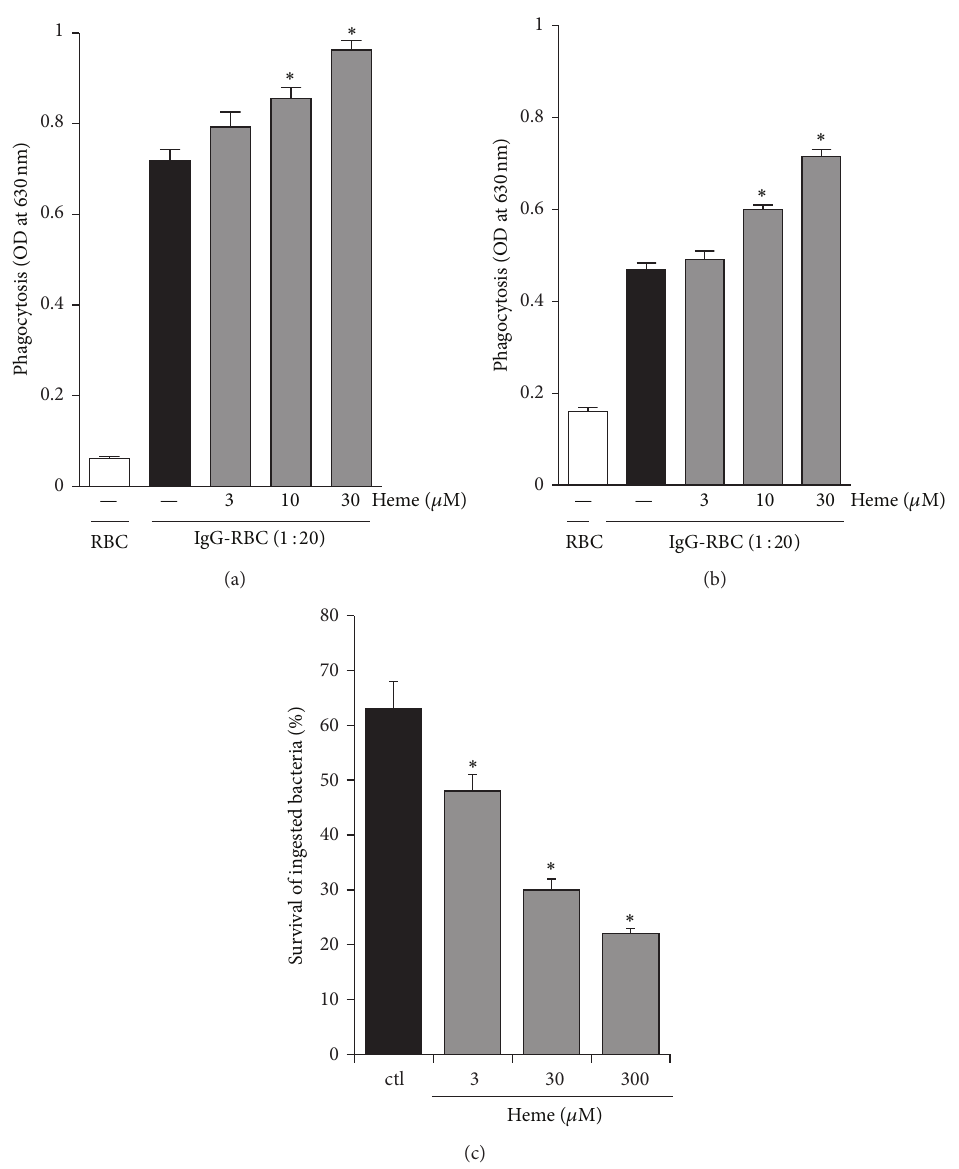
Figure 7: Heme modulates phagocytosis and killing by AM. Rat AMs (2 × 10 6 /mL) were cultured in the absence or presence of heme (3–300 𝜇 M) for different periods of time. (a), (b) Following the incubation with heme for 10min (a) or 24 h (b), IgG-SRBCs were added and cultures were incubated for an additional 90min at 37 ∘ C. Phagocytosis was assessed by a colorimetric assay as described in Section 2. (c) Following the incubation with heme (3–300 𝜇 M) for 10min, cells were infected with opsonized K. pneumoniae for 30min to allow phagocytosis to occur. The intensity of the absorbance at 595 nm is directly proportional to the number of intracellular bacteria associated with the macrophages. Results are expressed as mean ± S.D. of three independent experiments. RBC, macrophage exposed to unopsonized RBC. ∗ 𝑃 < 0.05 compared with control